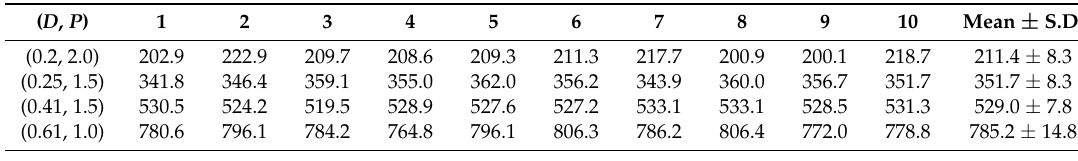
Table 1. All the measured diameters for the four hydrogel fibers (unit: µ m).